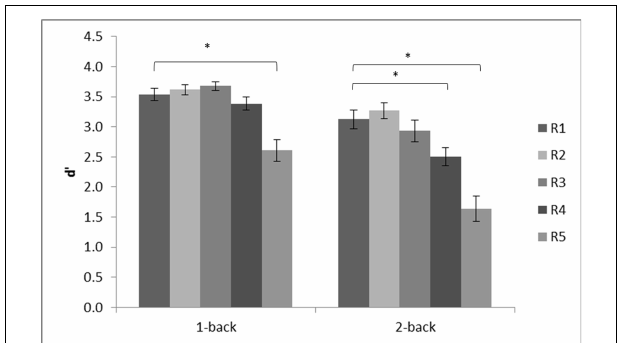
FIGURE 2 | Mean d ′ in each of the conditions of the n -back experiment. R1 (720 × 480 pixels); R2 (180 × 120 pixels); R3 (90 × 60 pixels); R4 (24 × 16 pixels); R5 (12 × 8 pixels). Error bars show standard error. Brackets show significant differences, * p < 0.05.